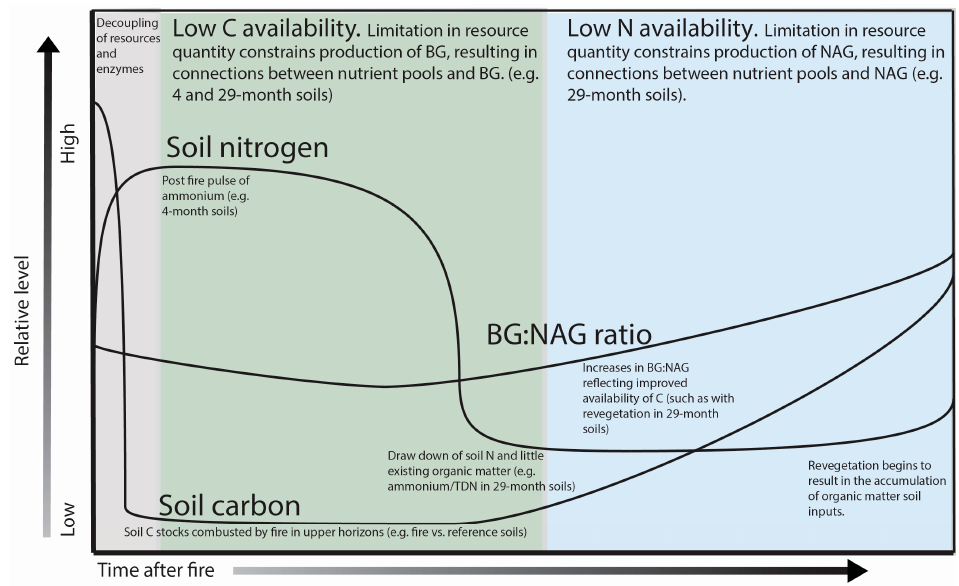
Figure 2. Soil resource and extracellular enzyme dynamics on a short timescale (<3 years) after a forest fire.